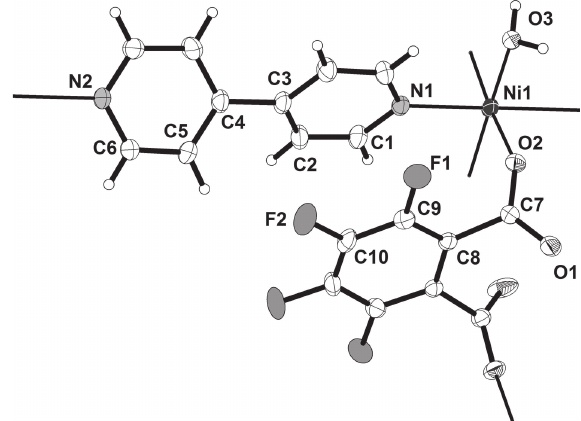
Table 1: Data collection and handling.